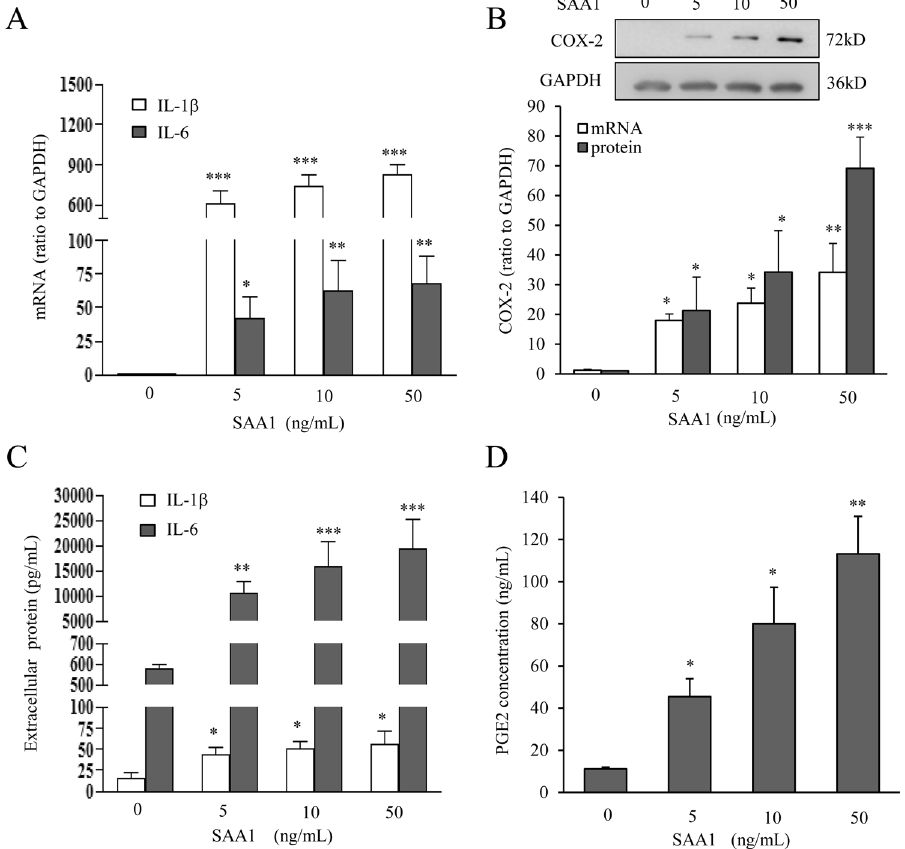
Figure 2. Induction of IL-1 β , IL-6 and COX-2 by SAA1 in human amnion fibroblasts. (A–D) Effect of SAA1 (5, 10 and 50 ng/mL, 24 hours) on the amounts of IL-1 β , IL-6 mRNA (A, n = 4), COX-2 mRNA and protein ( B ) n = 4), IL-1 β and IL-6 secretion (C, n = 5), and PGE2 secretion (D, n = 3) in human amnion fibroblasts. Top panel of B is a representative immunoblot. Data are the means ± SEM. Statistical analysis was performed with one-way ANOVA test. * P < 0.05, ** P < 0.01, *** P < 0.001 vs. control